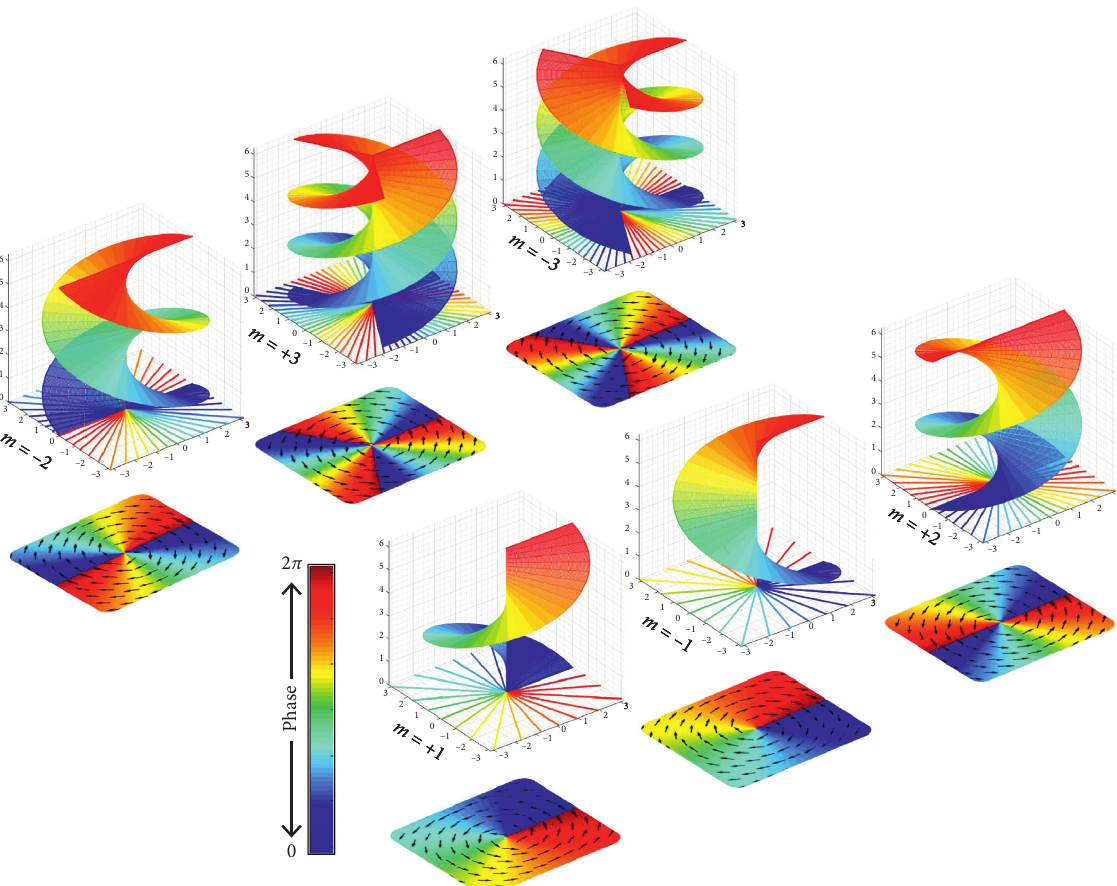
Figure 1: Phase distributions, phase gradients, and wavefronts of phase singular beams with different topological charges. Phase contours are shown below each